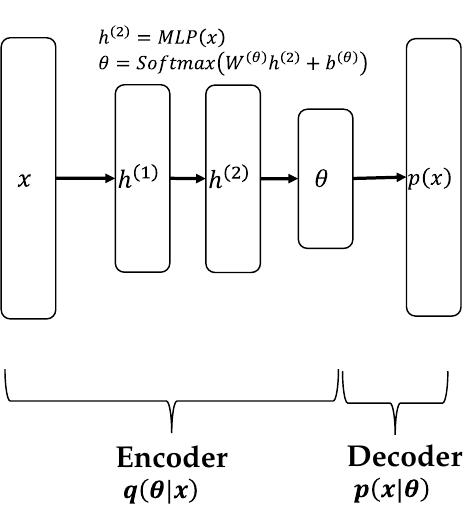
Figure 3. WAE base model Figure 3. WAE-based